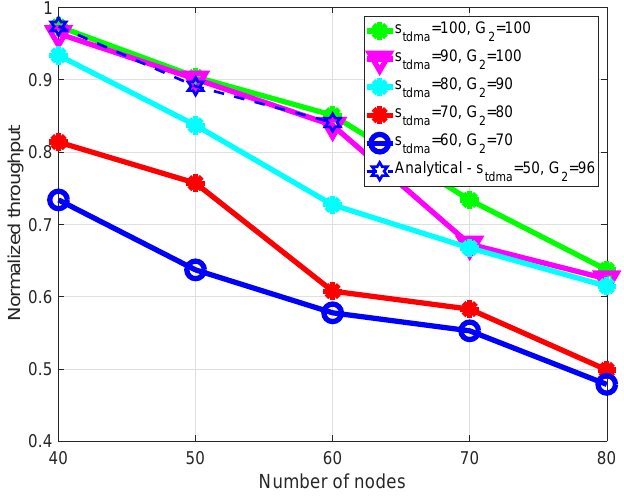
Figure 10. Normalized